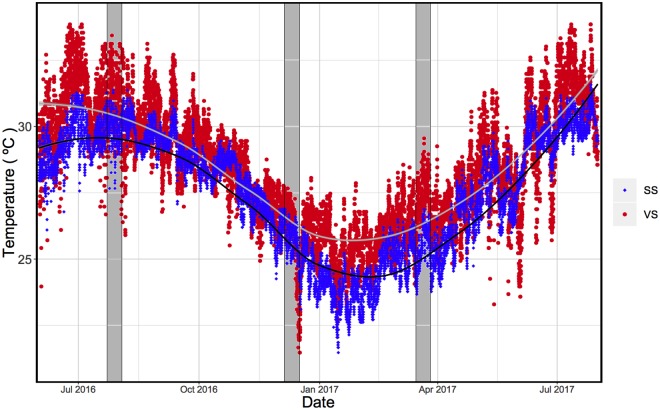
Seawater daily temperatures recorded for June 2016 to July 2017 at both sites.SS = Stable Site, VS = Variable Site. Each dot represents hourly measurements. The black line indicates the mean daily temperature in SS and the grey line represents the mean daily temperature in VS. Vertical grey bands represent each sampling time (August, December 2016 and March 2017).